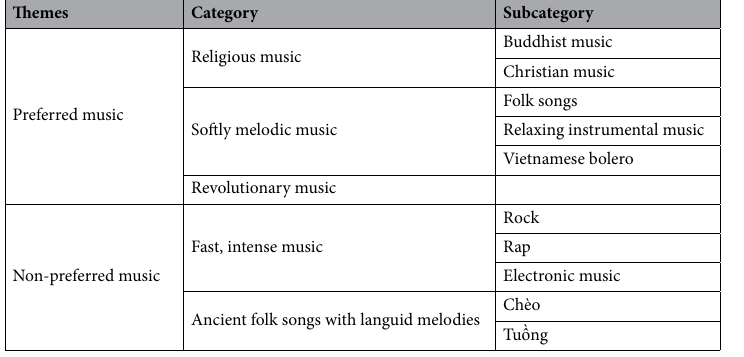
Table 4. Preferred and non-preferred music